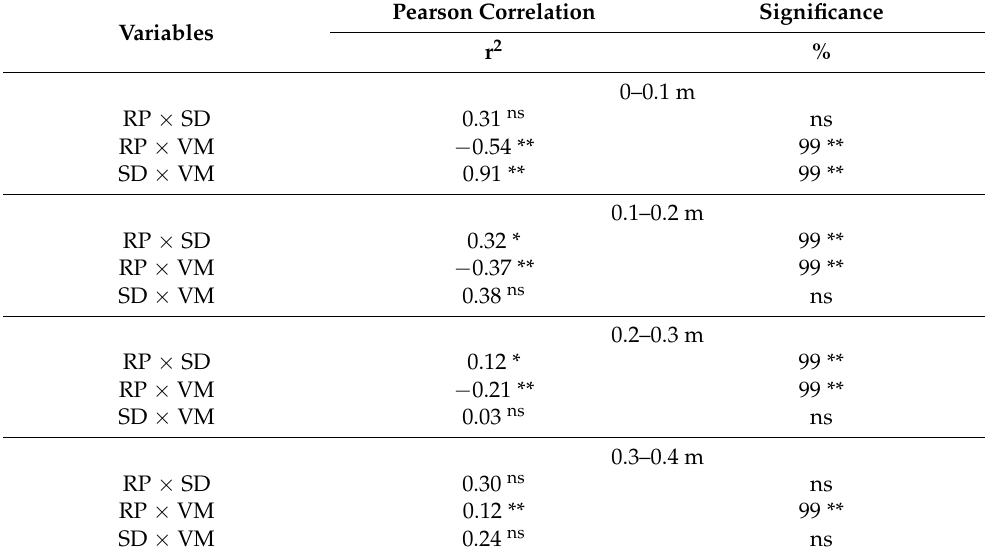
Table 2. Pearson’s correlations between the values of soil resistance to penetration (RP), soil bulk density (SD), and volumetric moisture (VM) between